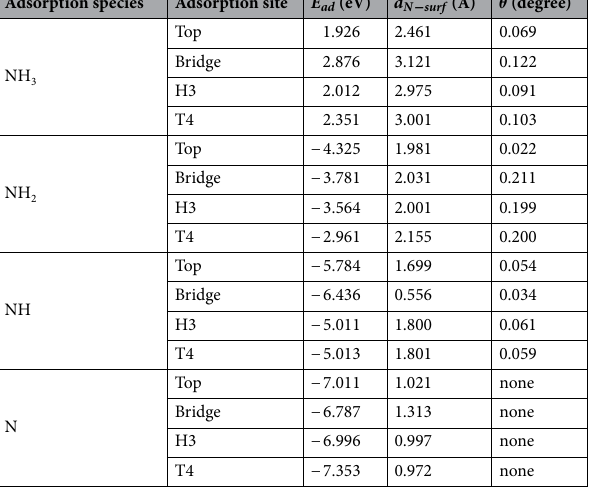
Table 3. Structure parameters, stable adsorption sites at NH n adsorbed on the AlN (0001) surface and the corresponding adsorption energies. E ad represents the adsorption energy. d N − surf represents the average distance of N atoms of NH n with the surface atoms. θ represents the angle between the NH n and the AlN (0001) surface.